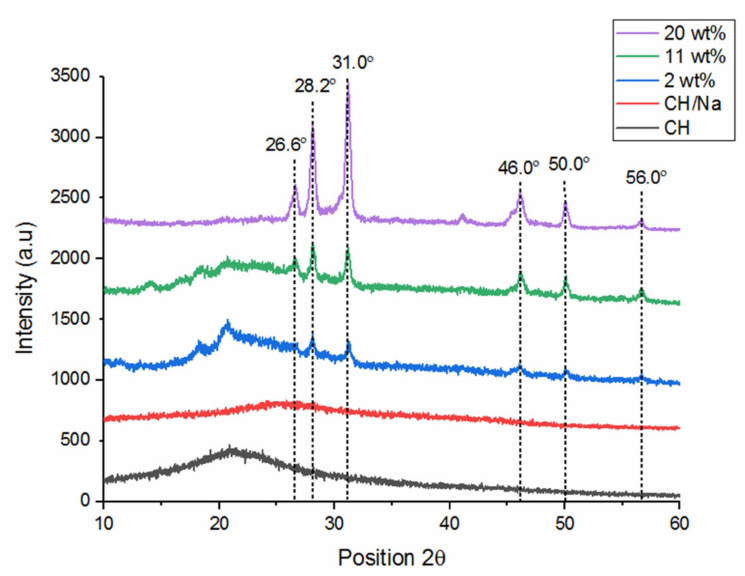
Figure 1. X-ray diffraction pattern for CH polymer, CH/Na polymer, and CH/Na/CuSe polymer matrix at different concentrations of CuSe: 2 wt%, 11 wt%, and 20